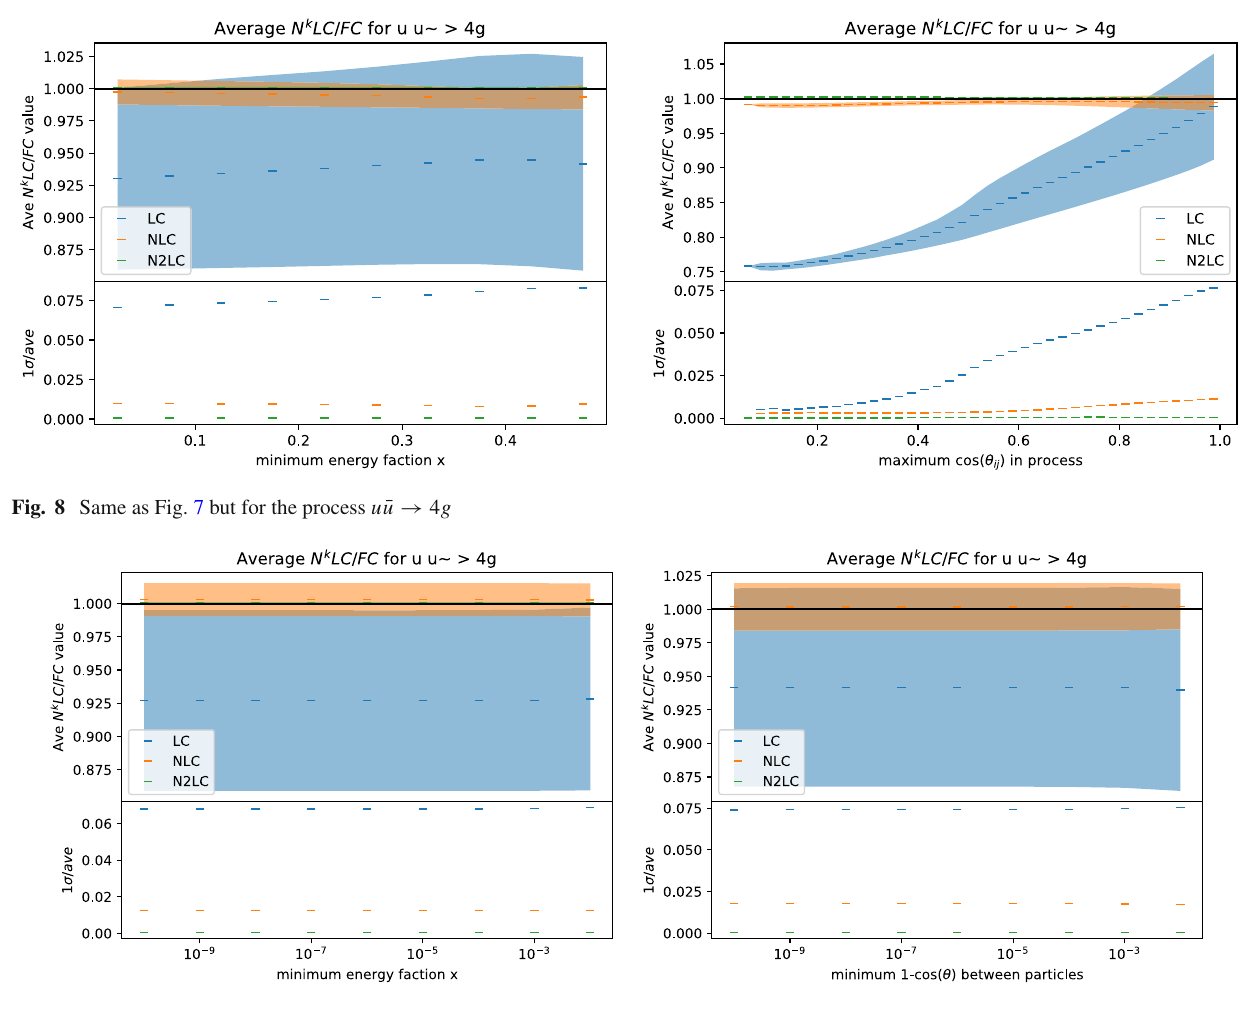
Fig. 9 The accuracy and precision of the colour expansion in the soft and collinear limits for u ¯ u → 4